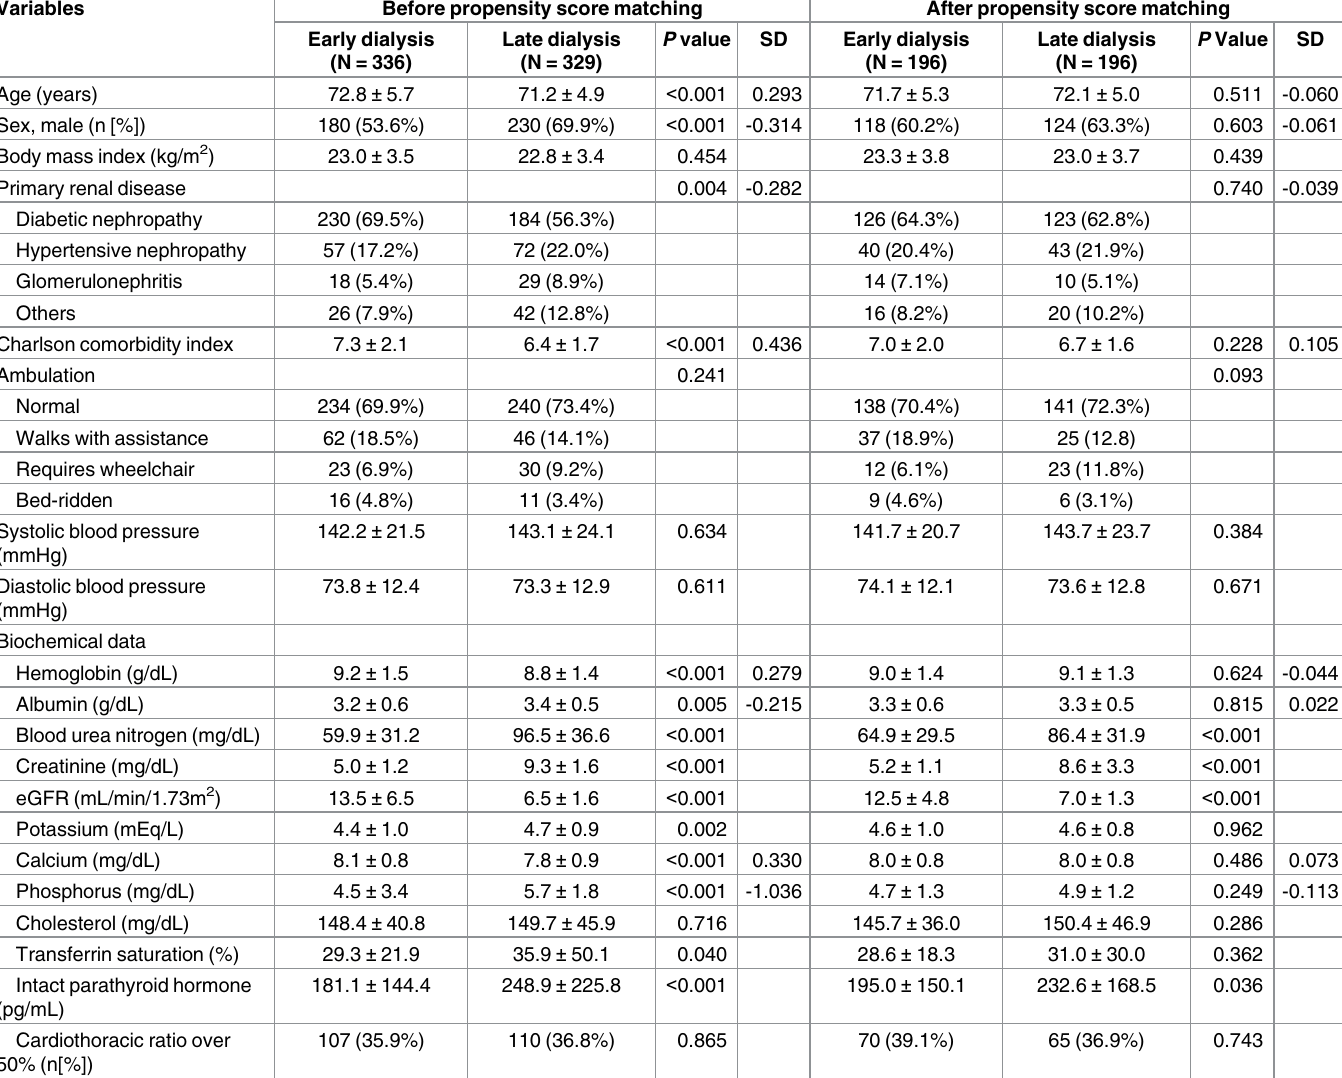
Table 1. Baseline characteristics before and after propensity score matching at the start of dialysis in the 2 groups based on the timing of dialysis initiation stratified by the median eGFR before